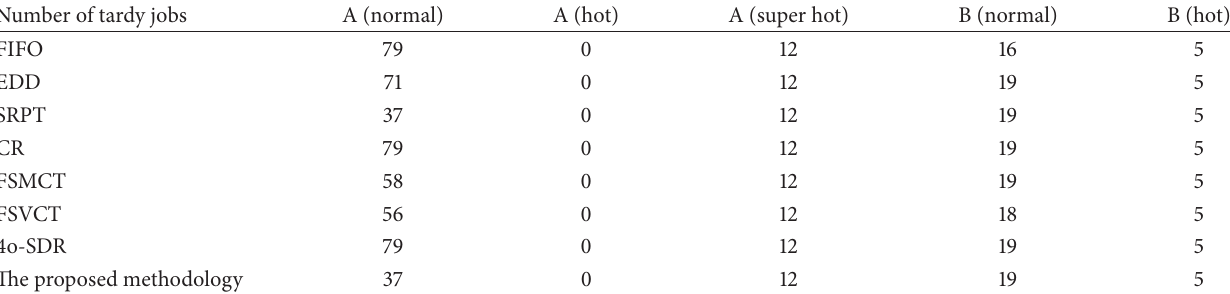
Table 10: The performances of various approaches in the number of tardy